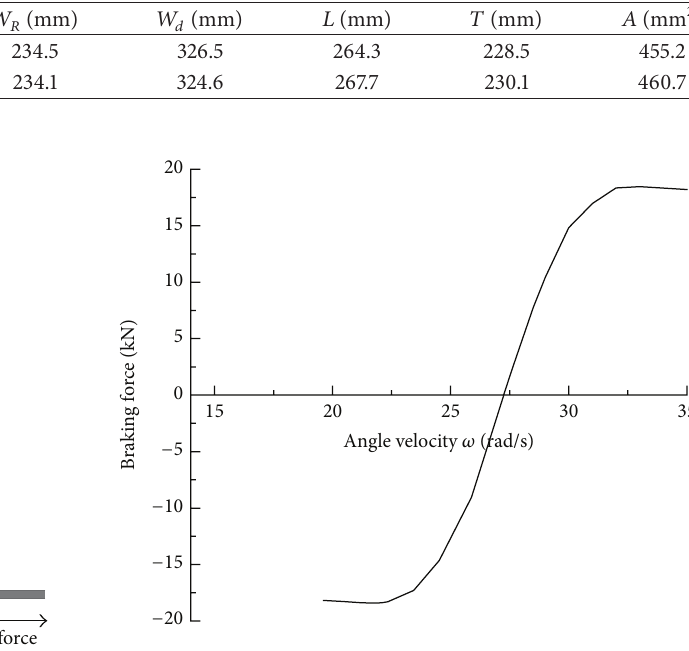
Figure 7: The relationship between braking force and angle velocity ( 𝑉 = 50 km/h).